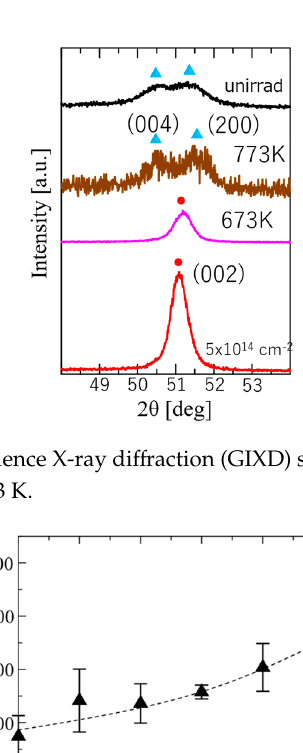
Figure 30. Effect of thermal treatment of Ni 3 Ta for ( a ) GIXD spectra and ( b ) Vickers hardness. Thermal treatment temperatures are shown at the right side of Figure 30a. The open circle in Figure 30b indicates the hardness value before thermal treatment. Hardness for the unirradiated specimen is also shown in Figure 30b. The change in the lattice structure by the irradiation and the subsequent thermal treatment for Ni-based intermetallic compounds is schematically shown in Figure 31 in terms of the free energy. The abscissa of the figure means the coordinates of lattice atoms in the specimens, corresponding to